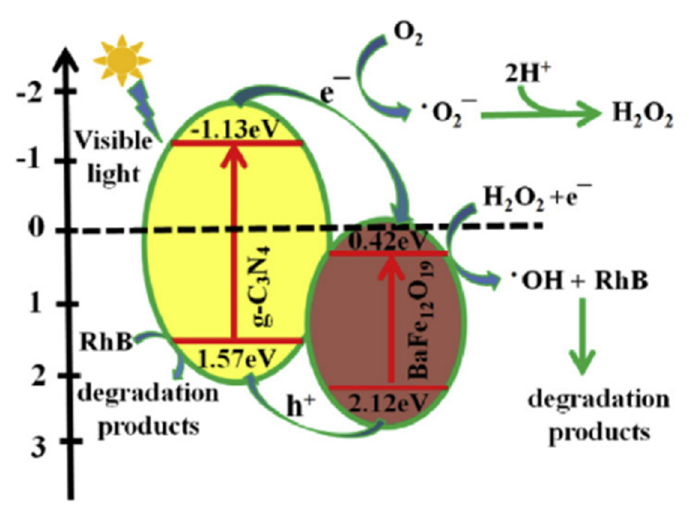
Figure 8. The schematic illustration of the proposed mechanism for the photocatalytic degradation of Rhodamine B on BaFe 12 O 19 ferrite/g ‐ C 3 N 4 composite. Reprinted with permission from [123]. Copyright (2017) Elsevier.